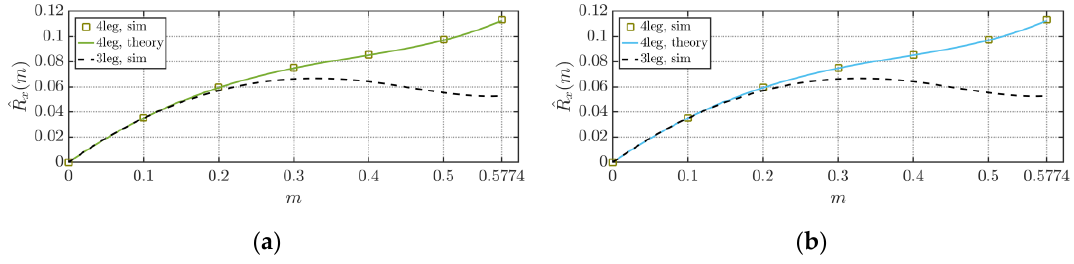
Figure 20. Normalized current ripple rms as a function of m for: ( a ) DPWMMAX; ( b ) DPWMMIN.